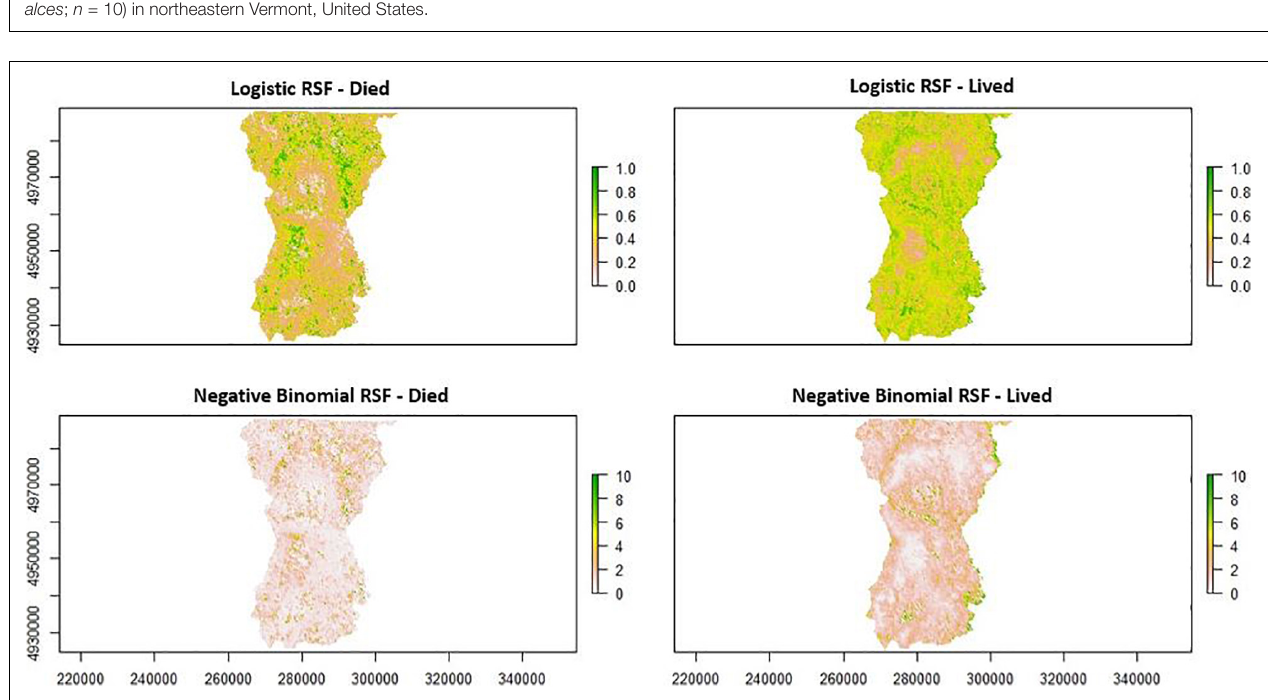
FIGURE 8 | Boxplot showing the impact of the top four principal components on habitat selection and fate (lived versus died) of adult female moose offspring ( Alces alces ; n = 10) in northeastern Vermont, United States.